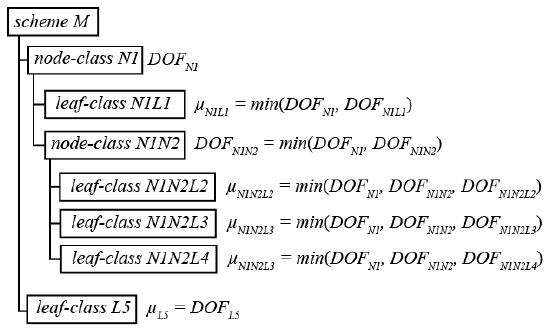
Figure 1. Hierarchical classification scheme with the (cid:1830)(cid:1841)(cid:1832)(cid:1871) of the N - and L -classes. Only L